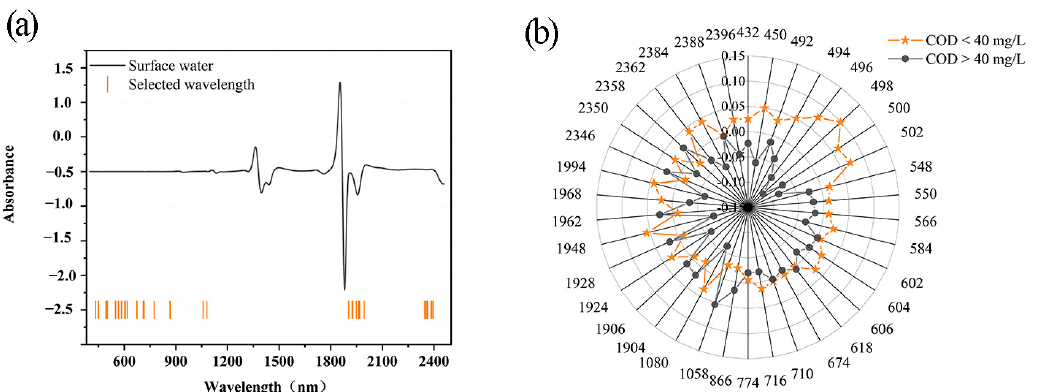
Figure 5. ( a ) Feature bands selected by competitive adaptive reweighted sampling (CARS) after second derivative (SD) pre-processing, ( b ) score plot of the feature bands.